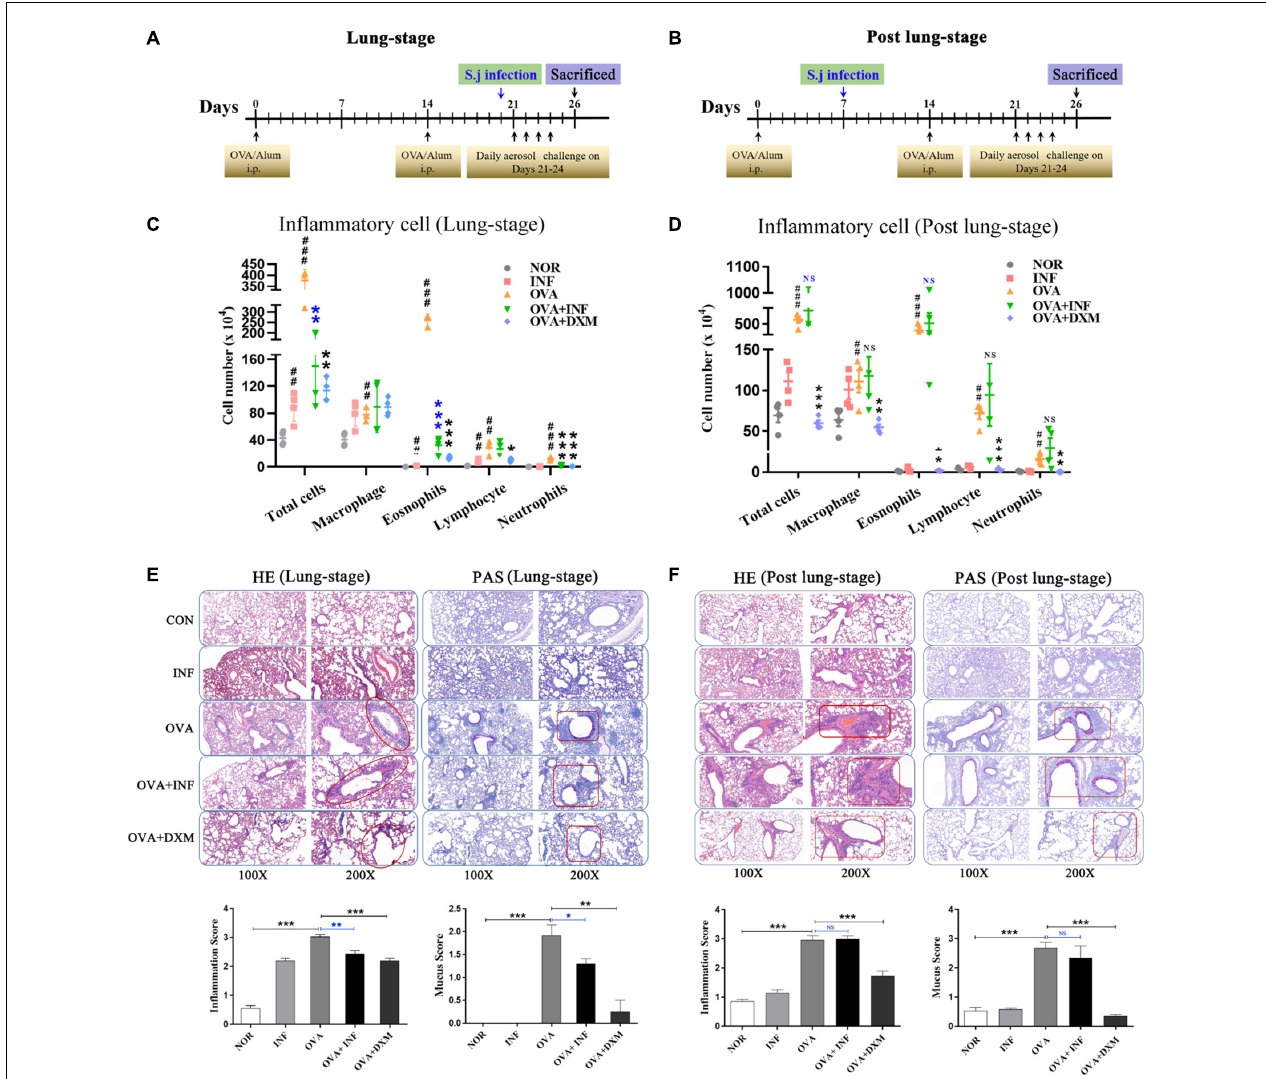
FIGURE 1 | Lung-stage S. japonicum infection alleviated the attack of OVA-induced AAI, whereas post–lung-stage infection did not. Experimental design of OVA-induced AAI treated with either lung-stage (A) or post–lung-stage (B) S. japonicum infection in murine model. (C,D) Inflammatory cell (total cell, macrophage, eosnophils, lymphocytes, neutrophils) infiltration in BALF of mice after OVA challenge was compared in NOR, INF, OVA, OVA + INF, and OVA + DXM groups ( n = 5 or 6 mice per group, experiment performed twice). (E,F) Representative images of H&E and PAS staining of lung tissue after OVA challenge. Statistical analysis of inflammation score and mucus secretion score are also shown in (E,F) , respectively, among five groups ( n = 5 or 6 mice per group, experiment performed twice). NOR, normal mice (without OVA sensitization and challenge); INF, mice without OVA sensitization and challenge but infected with schistosome; OVA, mice with OVA sensitization and challenge but without S. japonicum infection; OVA + INF, mice sensitized and challenged with OVA and treated with S. japonicum infection; OVA + DXM, mice sensitized and challenged with OVA and treated with dexamethasone. All data are shown as mean ± SEM. * P < 0.05, ** P < 0.01; NS, not significant by one-way analysis of variance (ANOVA) with Tukey test. #, ##, and ### indicate P < 0.05, < 0.01, and < 0.001, respectively, OVA versus NOR (C,D) . *, **, *** indicated P < 0.05, < 0.01, and < 0.001, respectively, OVA + INF or OVA + DXM versus OVA (C,D)